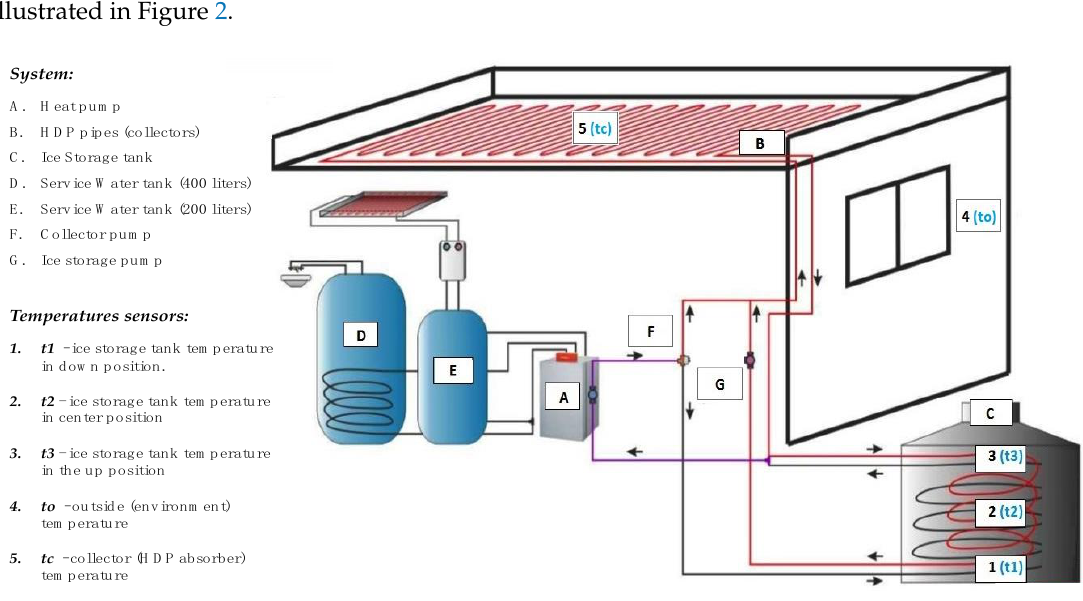
Figure 2. Combined ice storage system scheme.